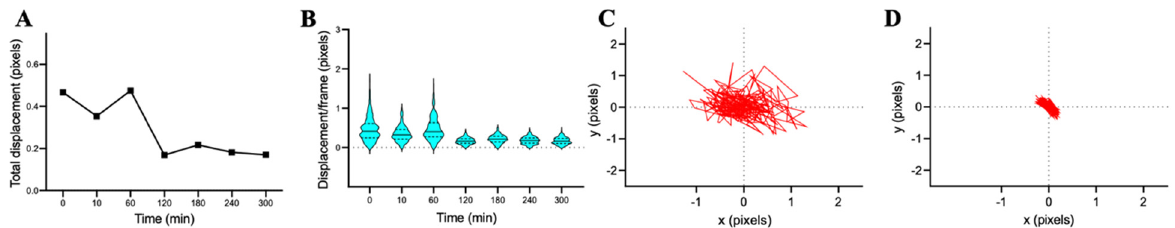
Figure 19. Effect of antifungal caspofungin (1 µ g/mL) on the cellular nanomotion of cell 1 in Figure 12 C ( C. albicans DSY1024). ( A ) Total displacements (pixels) as a function of time for cell 1. ( B ) Distribution of the displacement/frame as a function of time for cell 1. ( C ) X-y displacement of cell 1 before treatment. ( D ) X-y displacement at the time point of 300 min for cell 1.